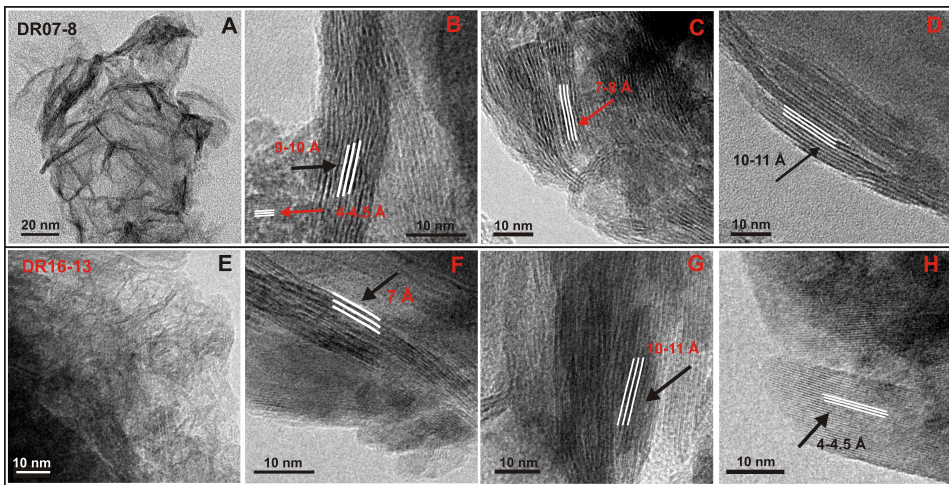
Figure 7. High resolution TEM photomicrographs. ( A , E ) Fe–Mn aggregates with very low crystallinity and few recognizable crystal planes. ( B ) Distinguishable 10 Å lattice fringes corresponding to 10 Å phyllomanganate (buserite/asbolane). ( C , F ) identified d-spacing belonging to vernadite/birnessite (7 Å) and ( B , H ) to goethite (around 4.2 Å). ( D , G ) lattice fringes corresponding to palygorkite (10–11